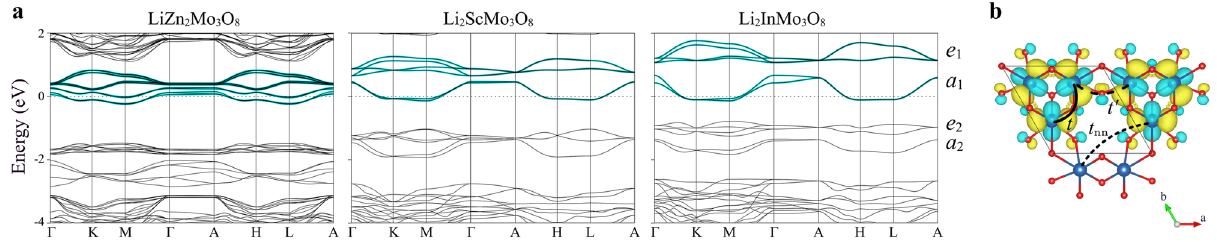
Fig. 2 Results of fi rst-principles calculations. a Band structures of LiZn 2 Mo 3 O 8 , Li 2 ScMo 3 O 8 and Li 2 InMo 3 O 8 , as obtained from local density approximation. The highlighted a 1 and e 1 states are used for constructing the low-energy models. b Wannier functions corresponding to the a 1 and e 1 bands spreading over the neighbouring Mo 3 O 13 clusters.